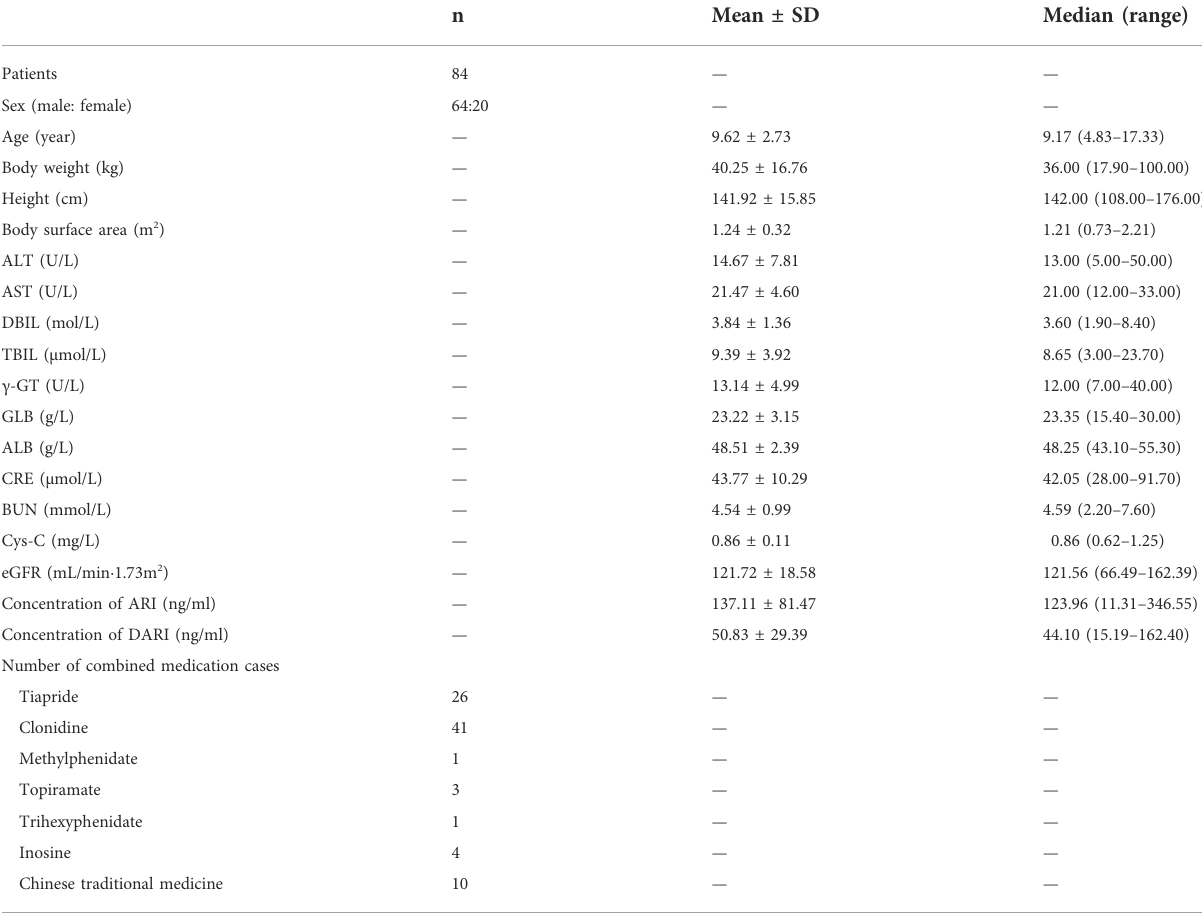
TABLE 1 Basic information of patients for the pharmacokinetics analysis in this study.